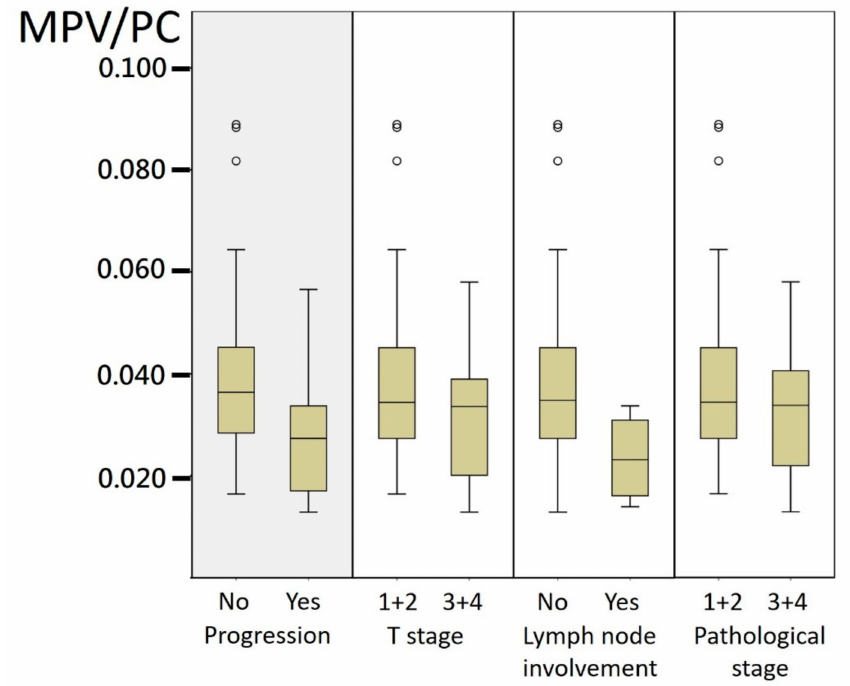
Figure 2. Box plot for mean MPV/PC ratio of different groups. MPV/PC: mean platelet vol- ume/platelet count.